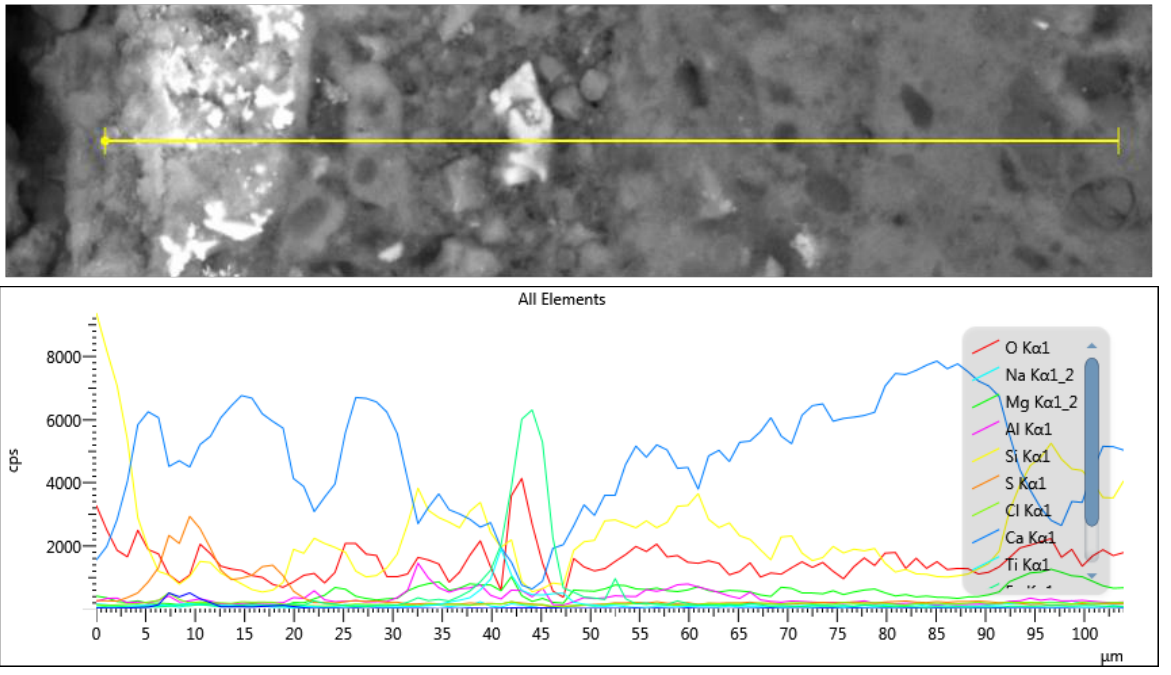
Figure 8. EDS line-scan analysis for the fresco with the red pictorial layer.